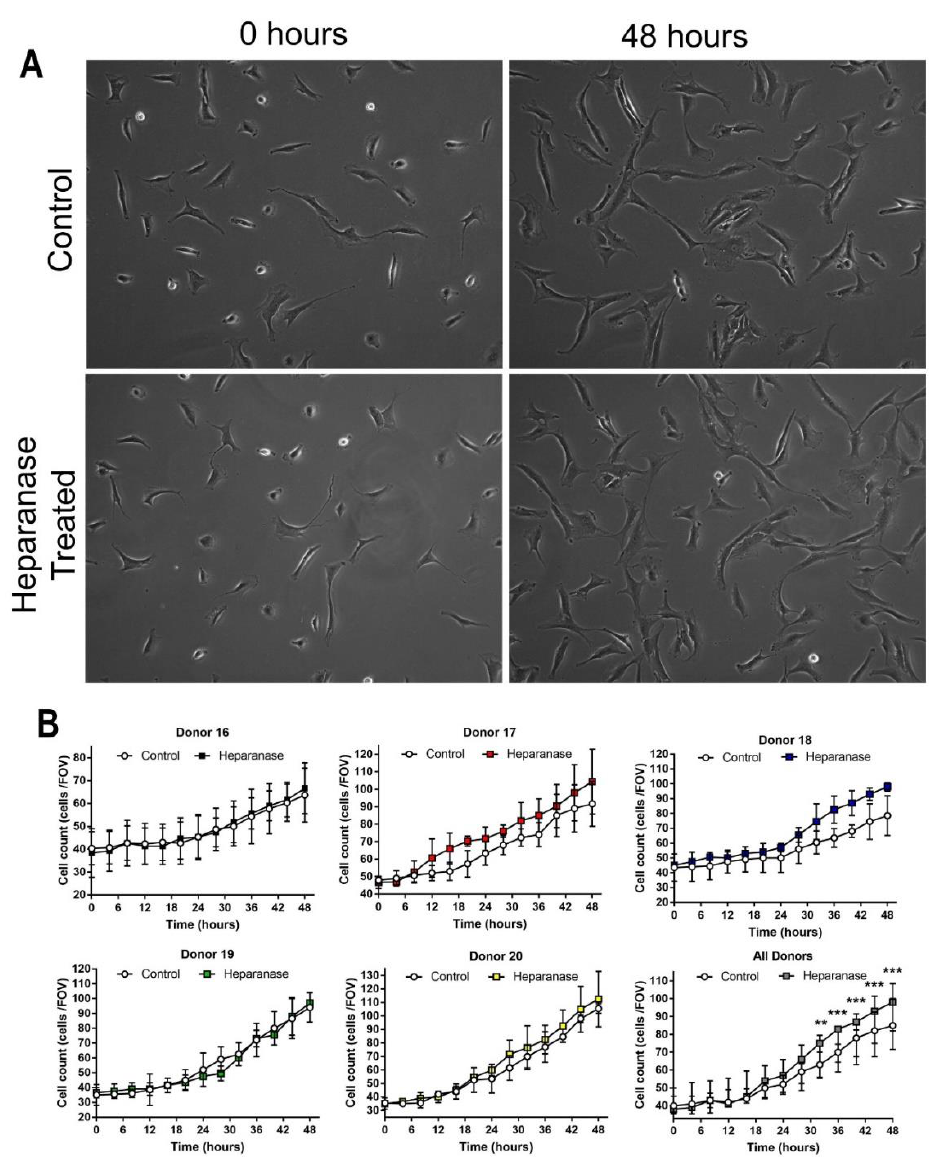
Figure 5. Morphology and growth kinetics of chondrocytes after treatment with heparanase ( n = 5). ( A ) Phase contrast images were acquired for control and heparanase-treated chondrocytes every 10 min at precise locations for 48 h. The representative images shown are of chondrocytes from donor 20 at t = 0 h and t = 48 h. ( B ) Growth kinetics of chondrocytes were established using a live cell imaging platform and analysis software during the 48 h heparanase treatment period. Individual plots are shown for donors 16 to 20 with mean and SD of cell counts from three FOV from three separate wells. The combined data for all five donors at every time point are also shown (bottom right). FOV = field of view. ** p < 0.05, *** p < 0.01.